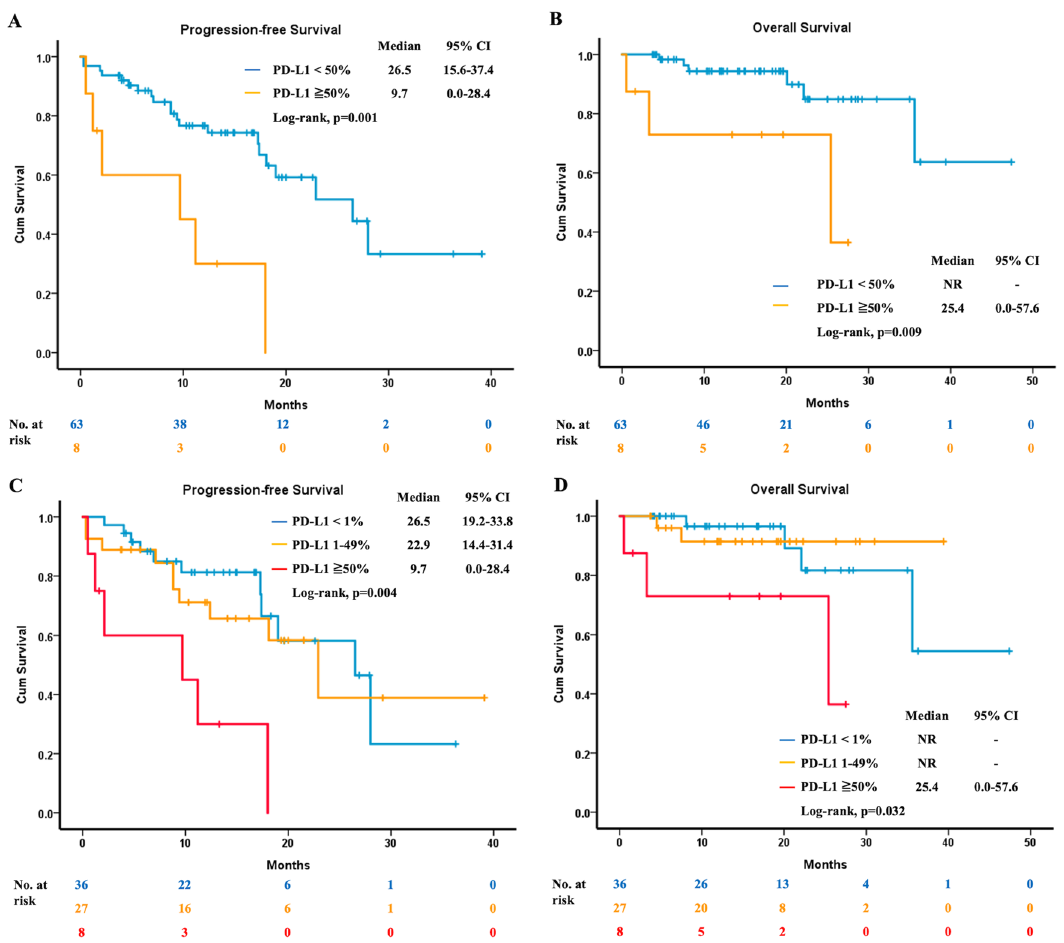
Figure 3. The clinical efficacy of osimertinib regarding different PD-L1 expression levels. ( A ) The median PFS in patients with PD-L1 < 50% and ≧ 50%. ( B ) The median OS in patients with PD-L1 < 50% and ≧ 50%. ( C ) The median PFS in patients with PD-L1 < 1%, 1 to 49% and ≧ 50%. ( D ) The median OS in patients with PD-L1 < 1%, 1 to 49% and ≧ 50%. PD-L1, programmed death-ligand 1; PFS, progression-free survival; OS, overall